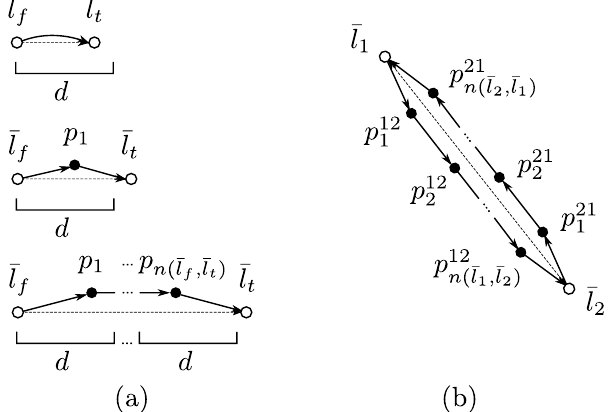
Figure A1. Interpolation of moves between two locations longer than d by intermediate positions p i . The figure ( a ) shows additional positions p 1 , . . . , p between two locations ¯ l f , ¯ l t based on the n ( ¯ l f ,¯ l t ) distance between them and the distance granularity. The solid arrows denote possible move actions. Note that the locations ¯ l f , ¯ l t are described by x , y coordinates in the MUSP M , therefore the